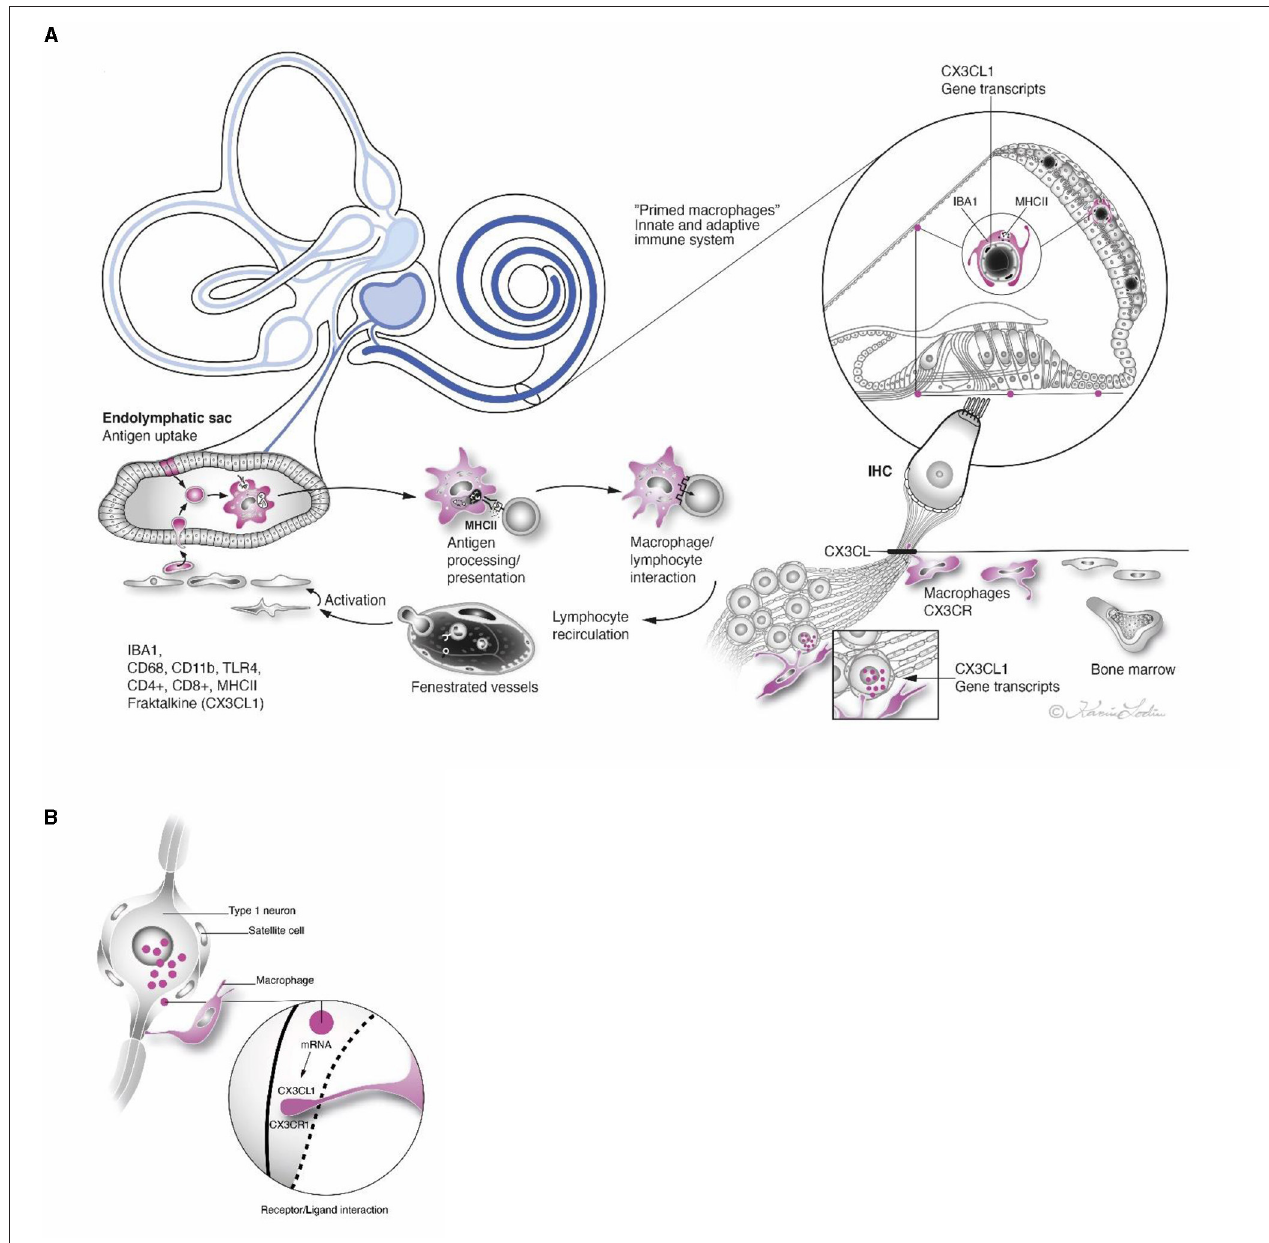
FIGURE 14 | (A) Antigen entering the inner ear from infection-prone areas may be thrust through the endolymphatic duct to the ES. The sac contains bone marrow-derived immune competent cells that may engulf and immune process agents with the help of MHCII and TLR4. These antigen-presenting cells may “prime” memory cells that reenter the inner ear via the circulation and form protective barricades in different regions. Strategic expressions of CX3CL1 gene transcripts are outlined. (B) Framed region in (A) show receptor/ligand interaction in satellite cell in higher